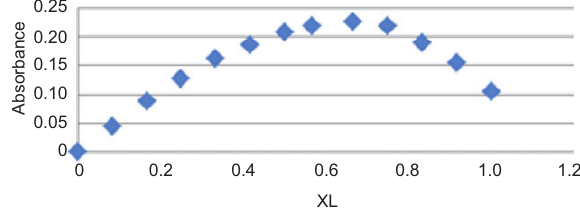
of the complex. A computer sample fitting of the absorb- ance-mole ratio data for Fe 3 + ion and adrenaline at 25 ° C is shown in Figure 4 . The resulting K parameters of the complex at different temperatures are listed in Table 4